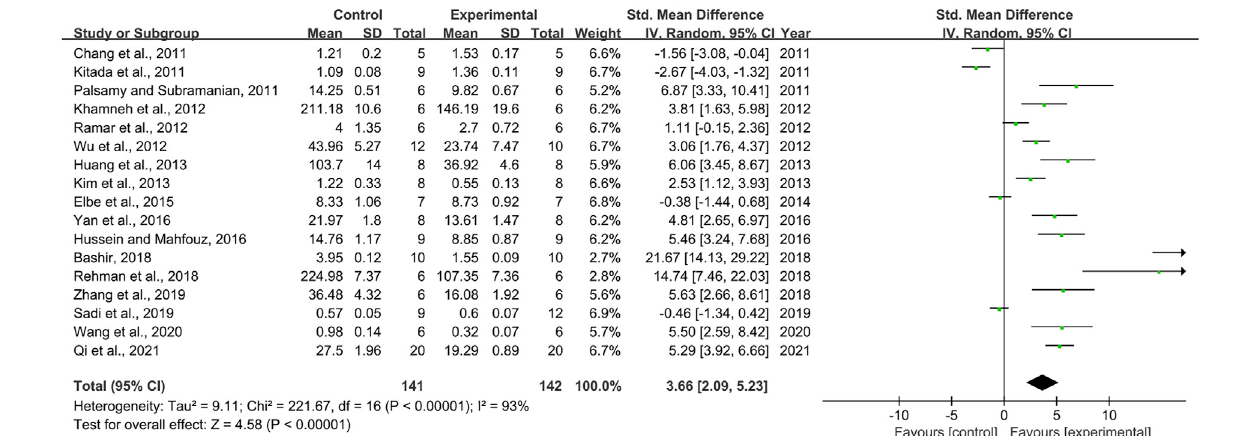
FIGURE 5 | Pooled estimate of SOD with RSV.